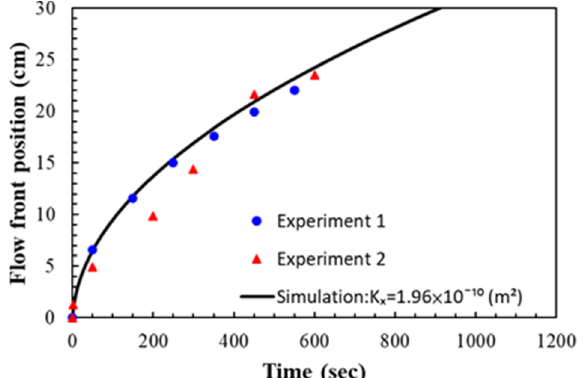
Figure 19. Comparison between experimental and simulated flow front positions in the case study of nine-layer fiber preform.